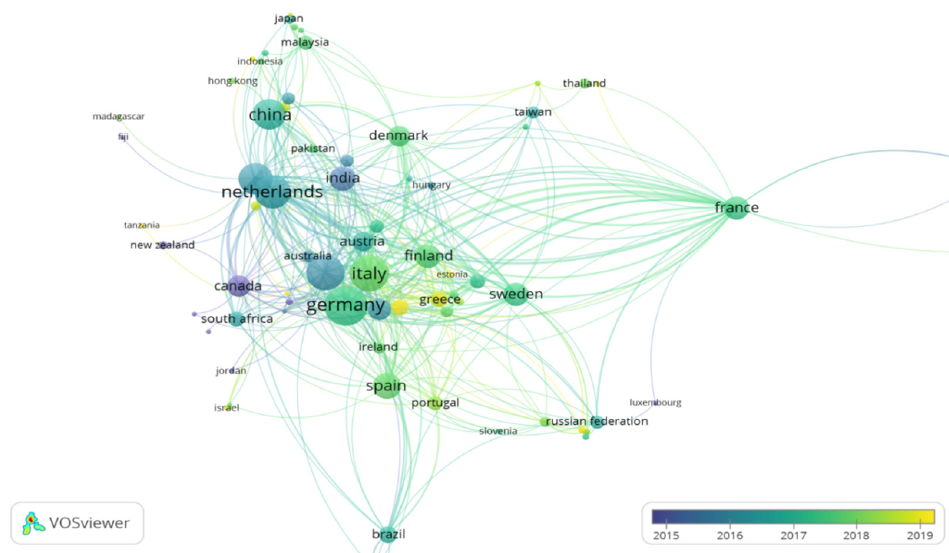
Figure 5. Co-authorship analysis/countries.